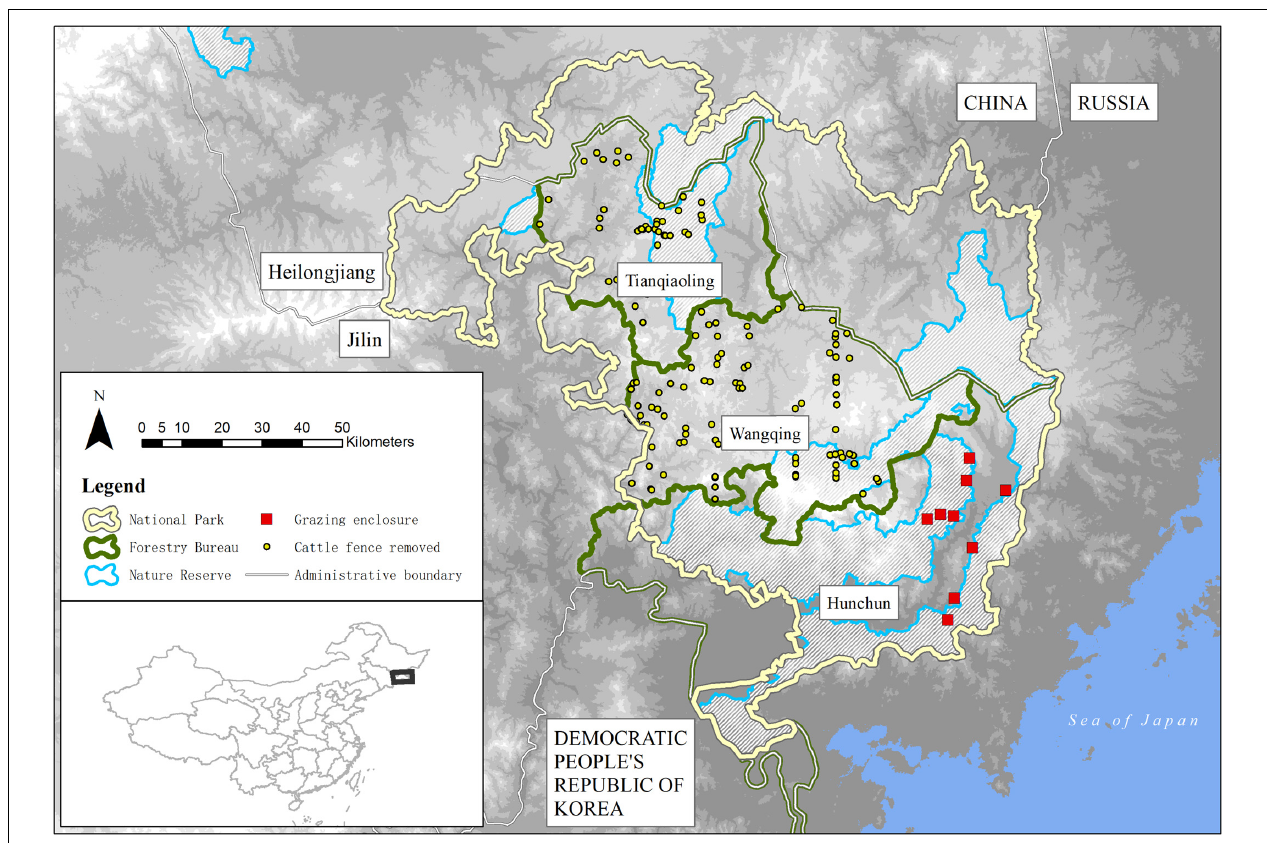
FIGURE 1 | Forestry Bureaus (FBs) and Nature Reserves in Northeast Tiger and Leopard National Park (NTLNP), Jilin/Heilongjiang Province, China sampled by ungulate and vegetation transect surveys. Transect lines intersect grazing enclosures (see section “Materials and Methods”). Base map is a digital elevation model. Cattle fence removals are shown for Tianqiaoling ( n = 55; length = 237.0 km) and Wangqing ( n = 109; length = 494.8 km) FBs only and do not infer individual fence length, shape, spatial extent or completeness of data (data provided by respective FBs in December 2018 for context only). The names and boundaries shown and the designations used on this map do not imply the expression of opinion whatsoever on the part of the authors concerning the legal status of any country, territory, city or area or of its authorities, or concerning the definitions of its frontiers or